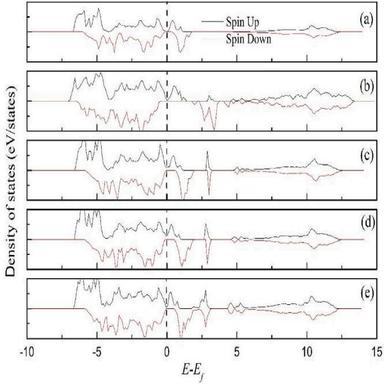
Total density of states of (a) NaNiO2, (b) NaNi0.963Ti0.037O2, (c) NaNi0.944Ti0.056O2, (d) NaNi0.917Ti0.083O2 and (e) NaNi0.833Ti0.167O2. The vertical dash line at zero point indicates the Fermi energy.